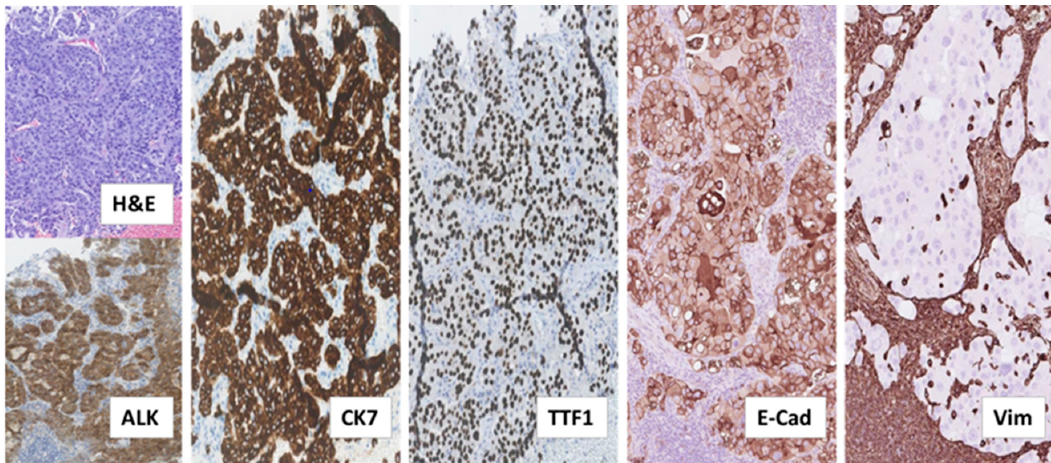
Figure 1. Histological examination of diagnostic biopsy from NSCLC metastasis to cervical lymph node. Tissue sections stained by hematoxylin and eosin (H&E) and the indicated immunostainings showed metastatic adenocarcinoma with tumor cells arranged in acinar, trabecular and solid structures. The tumor cells expressed the anaplastic lymphoma-kinase (ALK), consistent with ALK -rearrangement, as well as the adenocarcinoma marker Cytokeratin 7 (CK7) and the pulmonary marker Thyroid Transcription Factor 1 (TTF1). Additional immunostainings on deeper serial sections showed that the tumor cells expressed the epithelial marker, adhesion molecule E-Cadherin (E-Cad) and lacked expression of the mesenchymal marker Vimentin (Vim). In contrast, lymphocytes and histiocytes of the lymph node, including those infiltrating the tumor tissue did not express E-Cadherin and were positive for Vimentin. (All images: original magnification 100×).